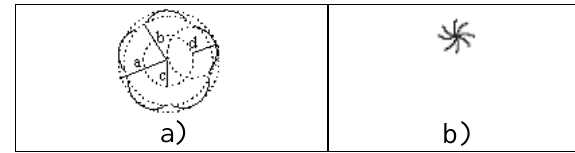
4 pav. Medžio topografinis sutartinis ženklas Fig 4. Topographic sign of a tree